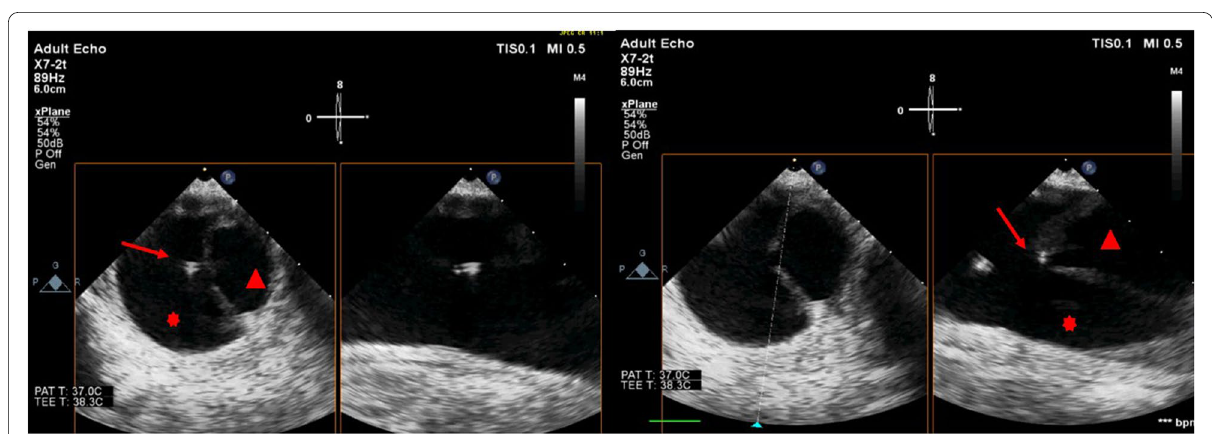
Fig. 3 Transesophageal echocardiography of the descending aorta in long and short axes. True lumen (red arrowhead) and false lumen (red asterix) are separated by an intimal flap of the aortic dissection, with a guide wire passing through the intimal tear from the true to the false lumen (red